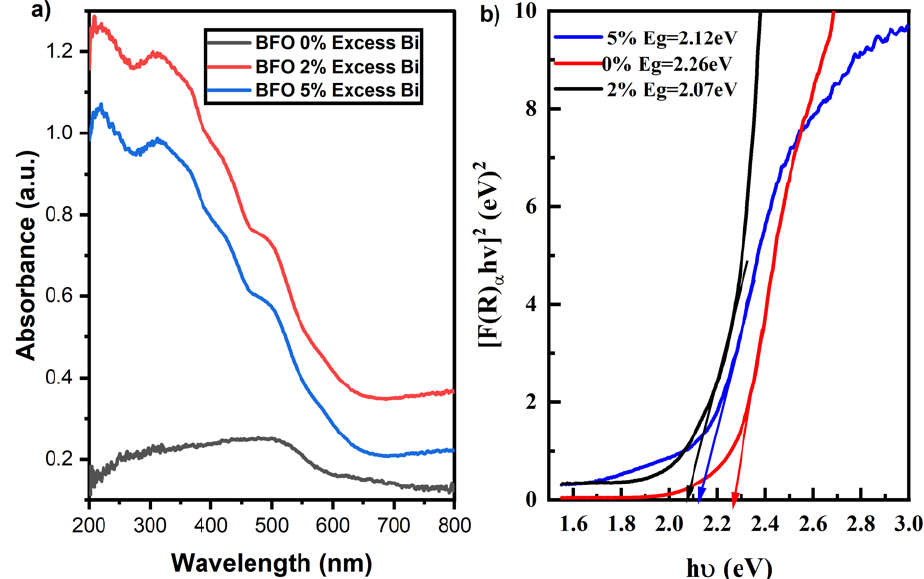
Figure 3. UV-Vis diffuse reflectance spectrum of BFO nanoparticles ( a ) and [F(R) α h υ ] 2 versus photon energy spectrum ( b ).